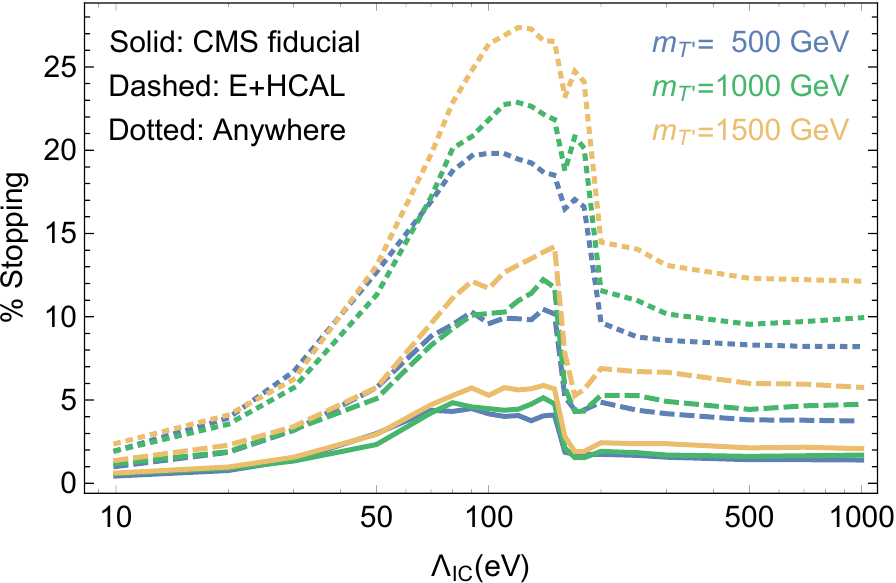
Figure 6 . Percentage of T 0 -like quirks that stop in CMS for a given con(cid:12)nement scale. The solid lines show the fraction of quirks that stop in the CMS (cid:12)ducial region ( j (cid:17) j < 1 : 0). Dashed lines display the fraction that stops in the entire calorimeter out to j (cid:17) j < 3 : 0. Dotted lines display the fraction of quirks that stop anywhere in the CMS detector (mostly in the muon system). As the mass of the quirks increases, the fraction that stops also